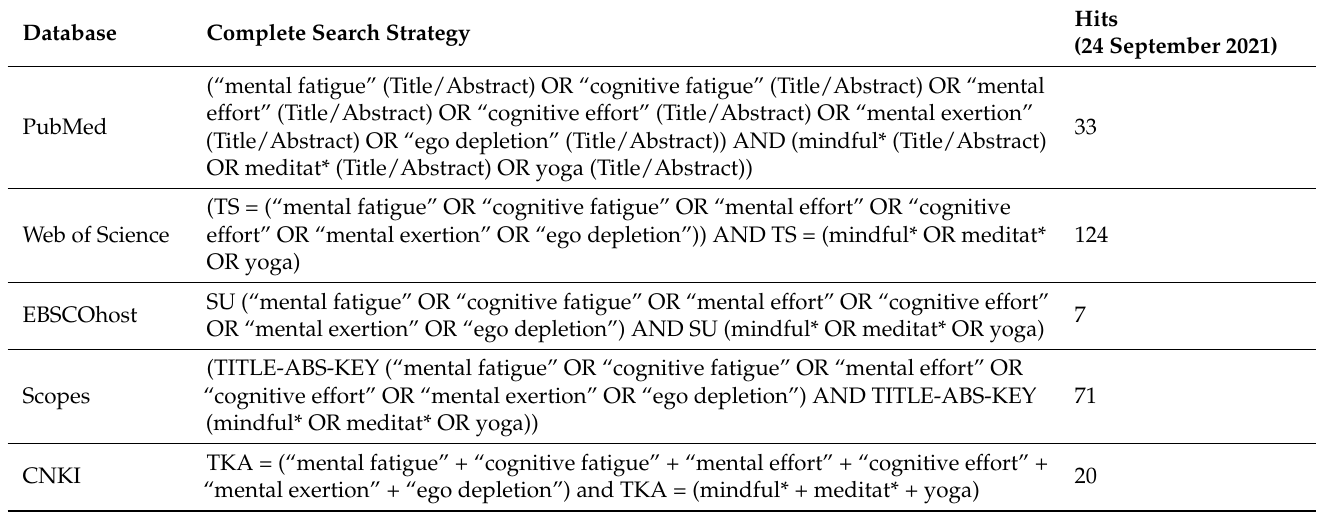
Table 2. Number of hits for the complete search strategy for the